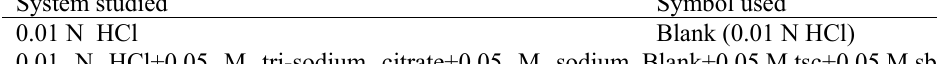
Table 1. The details of system studied System